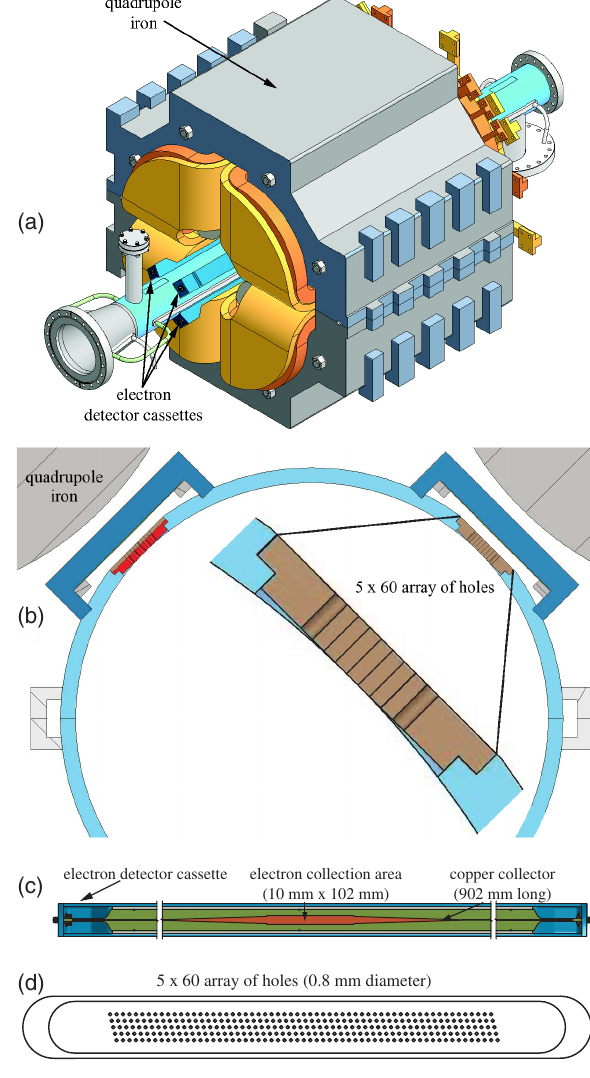
FIG. 1. (a) Vacuum chamber equipped with electron detectors in the quadrupole magnet. (b) Arrangement of two detectors in front of the magnet poles as seen from the positron arrival direction. (c) Geometry of the copper electrode biased at 50 V to collect electrons entering through the pattern of holes in the beam-pipe shown in (d). The rectangular region of the collector and the pattern of holes are each about 10 cm